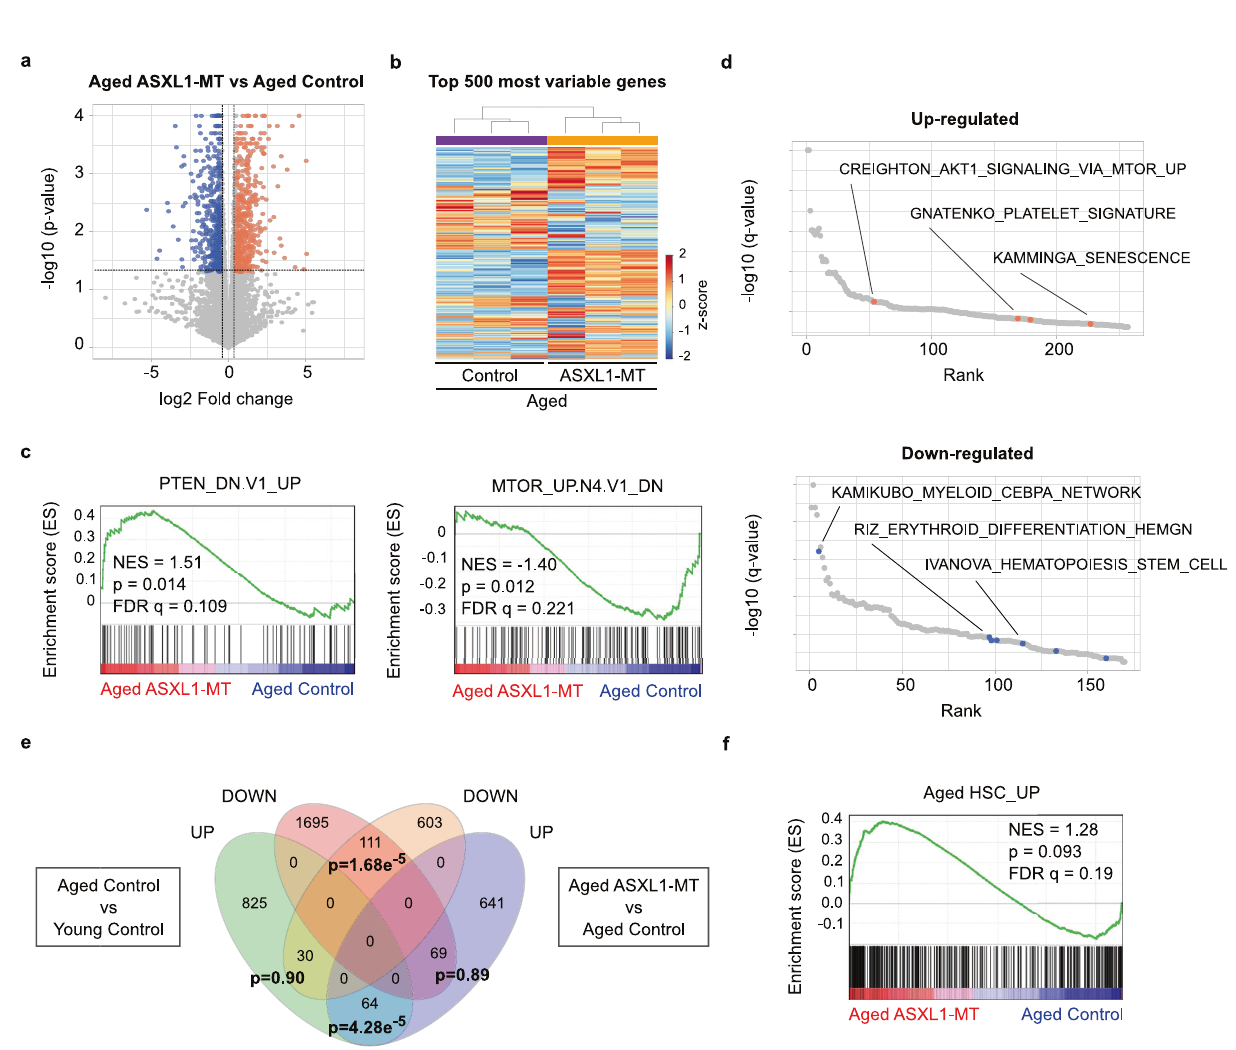
Fig. 10 ASXL1-MT enforces age-associated gene expression patterns. a Volcano plot displaying differentially expressed genes in LT-HSCs between aged Vav-Cre ASXL1-MT KI mice and aged-matched control mice ( n = 3). b The heatmap of the top 500 most variable genes ( n = 3). c GSEA using genesets up- regulated by PTEN de fi ciency (PTEN_DN.V1_UP) and negatively regulated by mTOR signaling (MTOR_UP.N4.V1_DN). d Up-regulated or down-regulated genesets (MSigDB C2_CGP: chemical and genetic perturbations) in LT-HSCs from aged Vav-Cre ASXL1-MT KI mice. Up-regulated genesets involved in Akt/mTOR signaling, platelet signature, and senescence signature are shown with orange circles. Down-regulated genesets involved in myeloid differenciation, erythroid differentiation, and HSC signature are shown with blue circles. e Venn diagrams showing up-regulated or down-regulated genes in LT-HSCs of (1) aged Vav-Cre ASXL1-MT KI mice compared to aged control mice and (2) aged wild-type mice compared to young wild-type mice (GSE48893). Statistical signi fi cances are assessed by two-sided Fisher ’ s exact test. f GSEA using a geneset up-regulated in LT-HSCs with age (GSE48893).